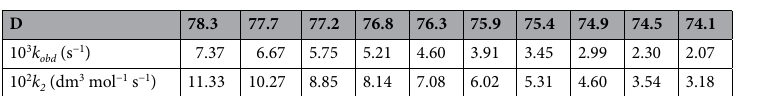
Table 2. Effect of system permittivity on the reduction rate of [Mo IV O 2 (paoH) 2 ] 2− by S 2 O 4 2− .